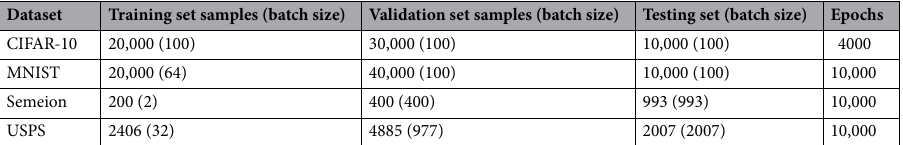
Table 7. Configuration of the datasets used in experiments.